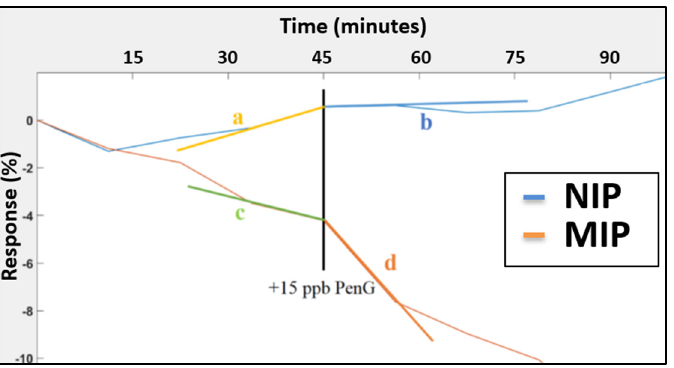
Figure 8. Example of how to quantify the sensors’ efficiency (with a, b, c, and d, the slope of the curves).